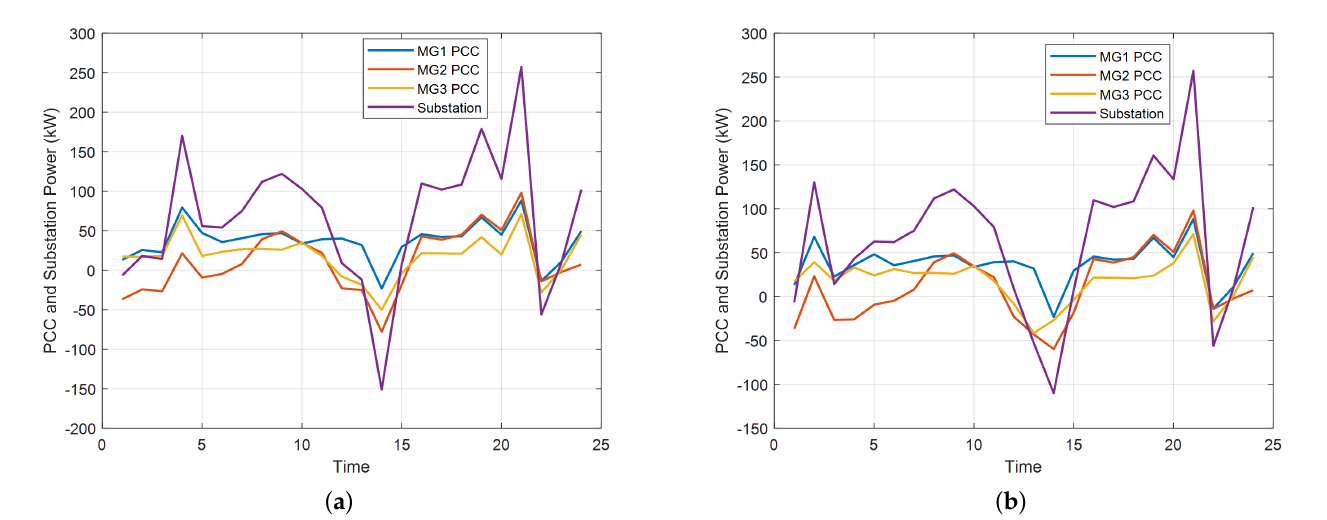
Figure 7. Calculated PCC power by different methods in grid-connected mode. ( a ) Centralized optimization. ( b ) MILP-based distributed optimization.